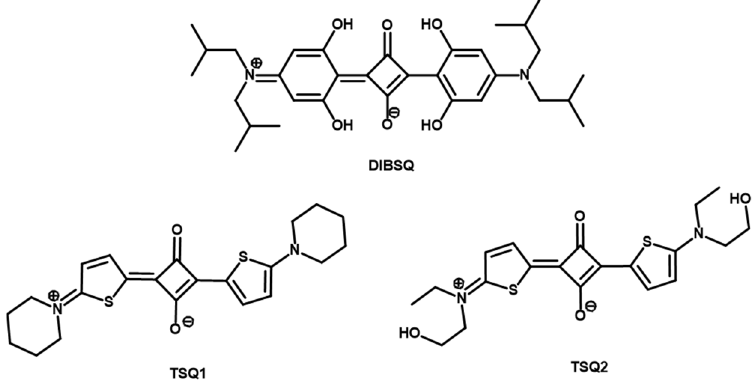
Figure 1. Molecular structures of investigated squaraine and